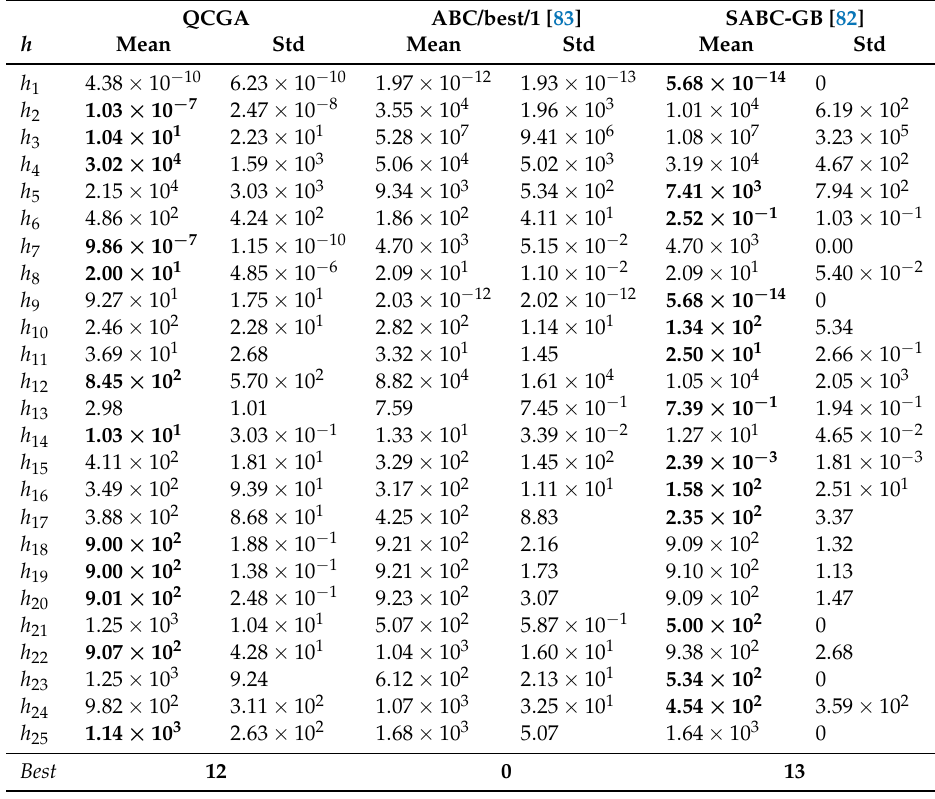
Table 10. Comparing the QCGA method with other benchmark methods using the hard functions h 1 – h 25 with dimension n =